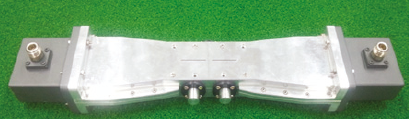
Figure 8: Photograph of the fabricated waveguide filter and measurement